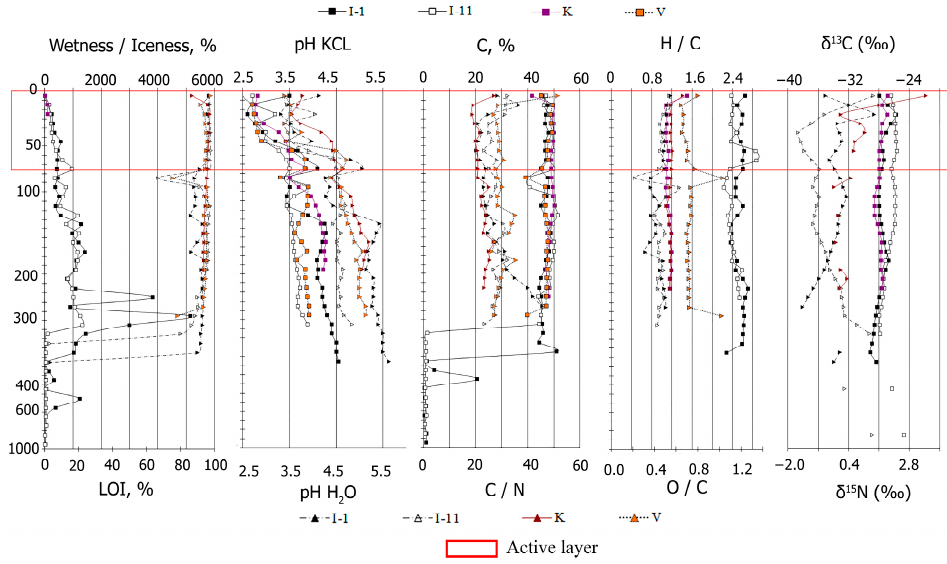
Figure 1. Physical and chemical properties of peat strata. LOI is loss of ignition.